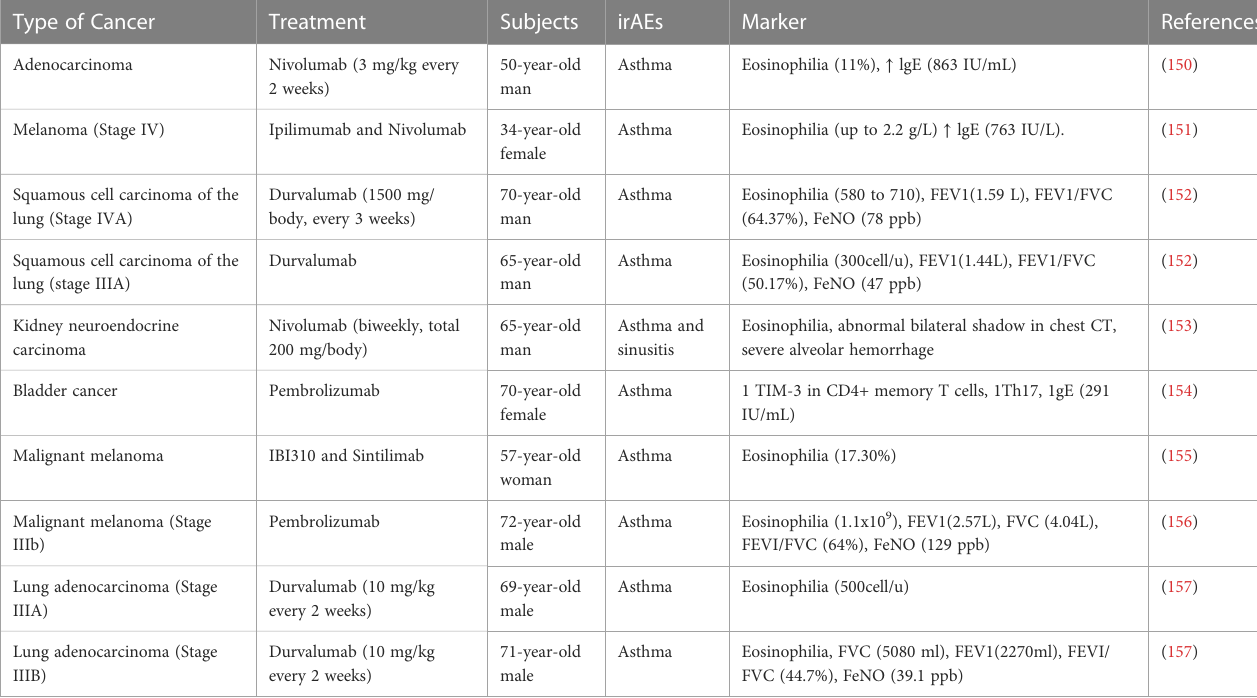
TABLE 2 Asthma as an IrAE in ICI-treated cancer patients reported in the literature. Type of